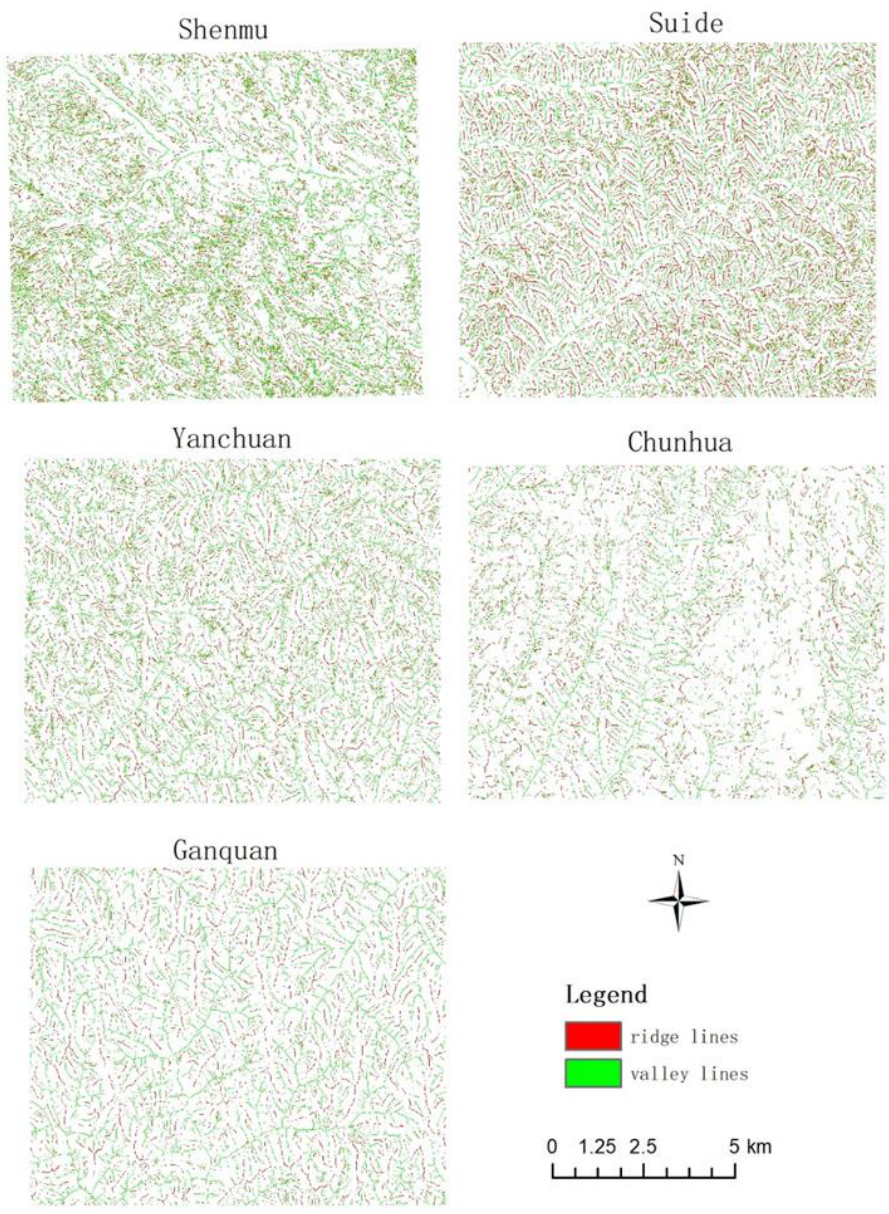
Figure 6. Valleys and ridges in study areas.